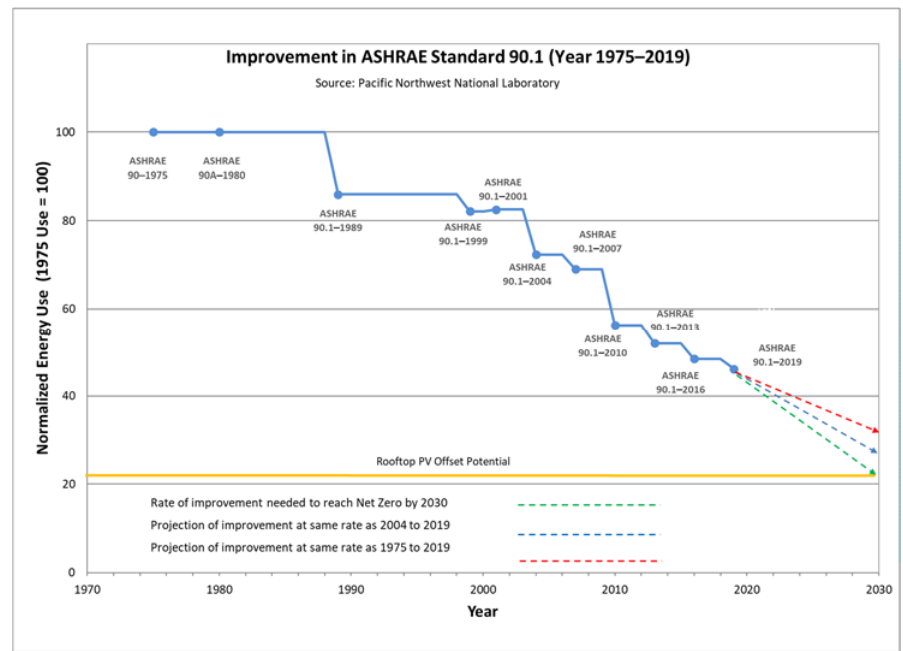
Figure 1. Improvement of Standard 90.1 over time [8].